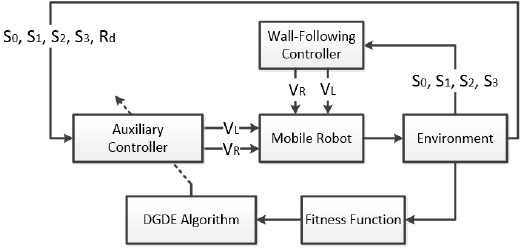
Figure 20. Block diagram of the cooperative carrying of mobile robots.